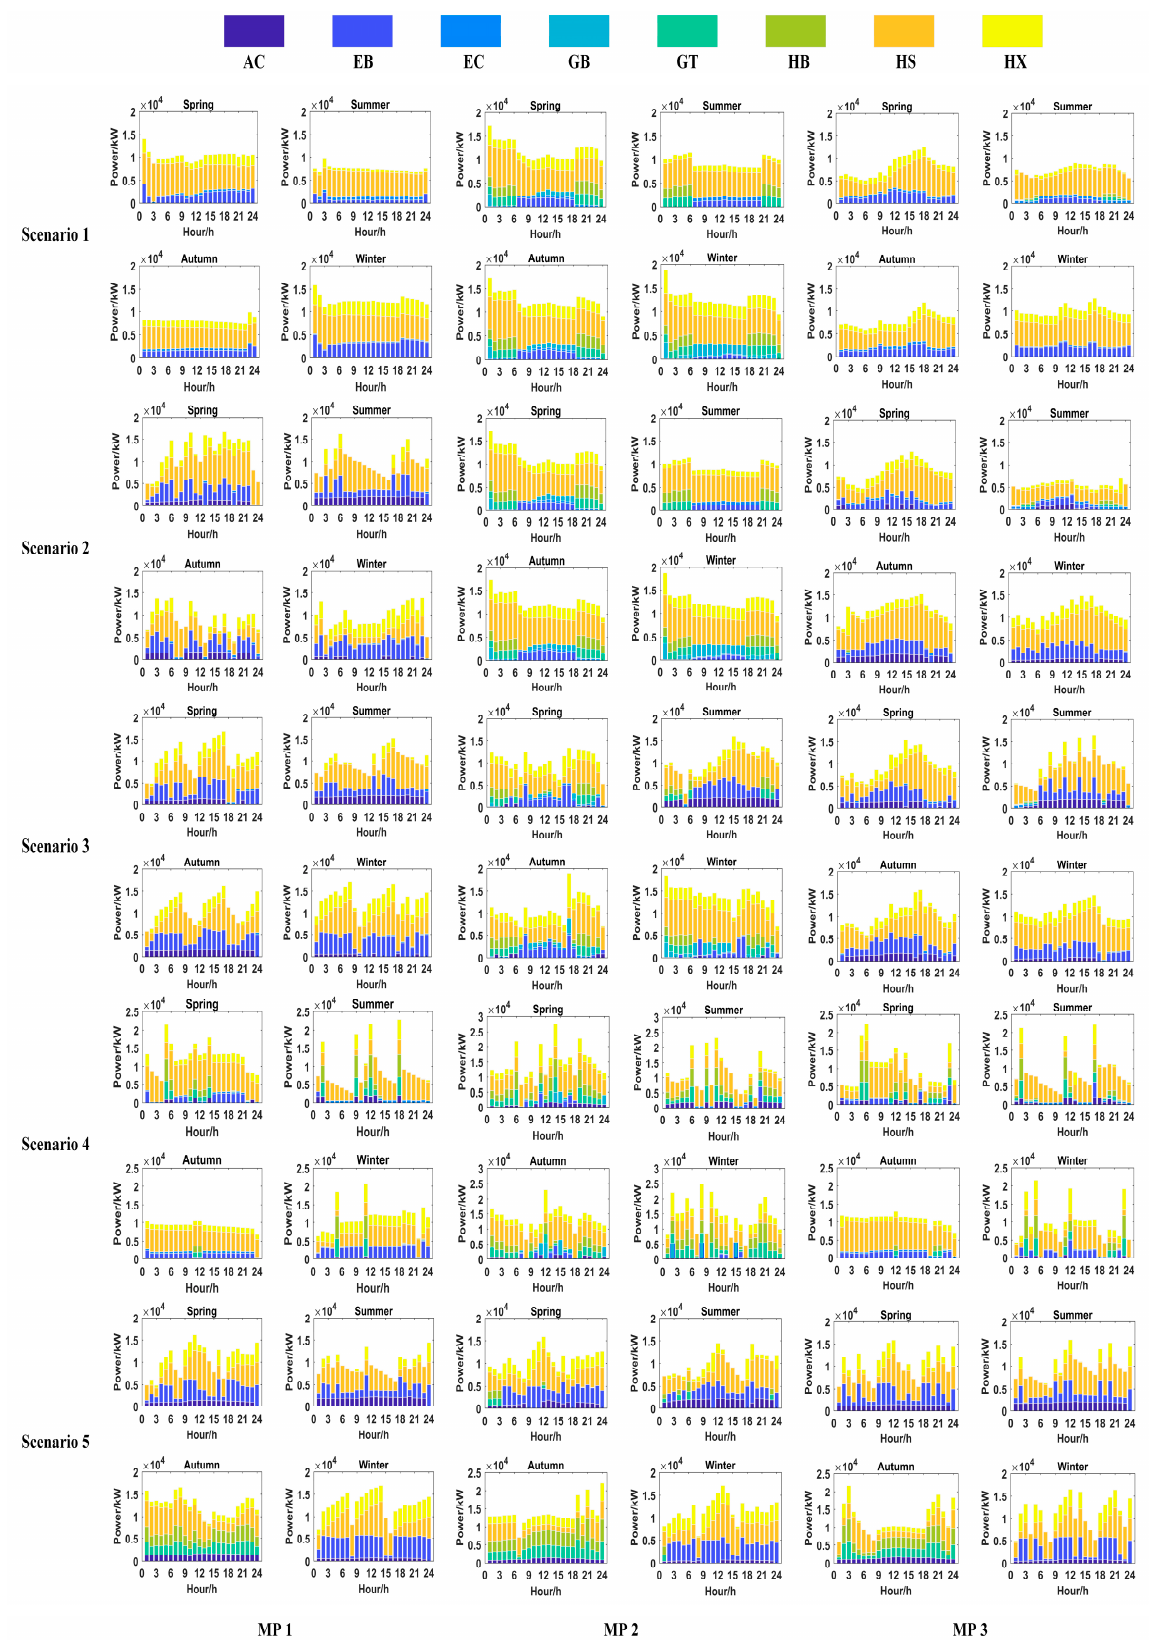
Figure 8. Output of equipment.